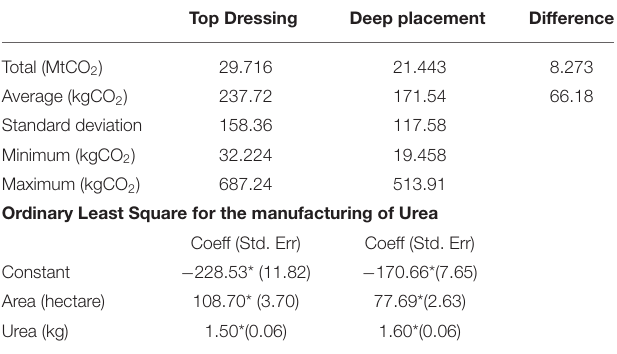
TABLE 9 | Inefficiency factors of TD and DP groups. TABLE 10 | GHG emissions from the manufacturing of urea and